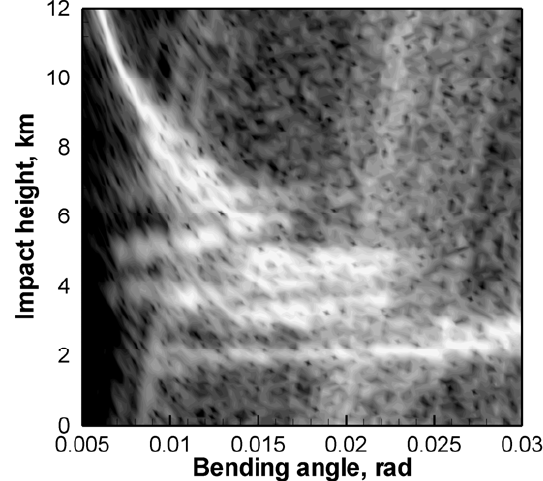
Fig. 3. Occultation event observed on 30 September 2007, UTC 12:42, 45.37N 29.34W. Strong multipath over Atlantic Figure 3. Occultation event observed on September 30, 2007, UTC 12:42, 45.37N 29.34W. 3 Strong multipath over Atlantic Ocean. 4